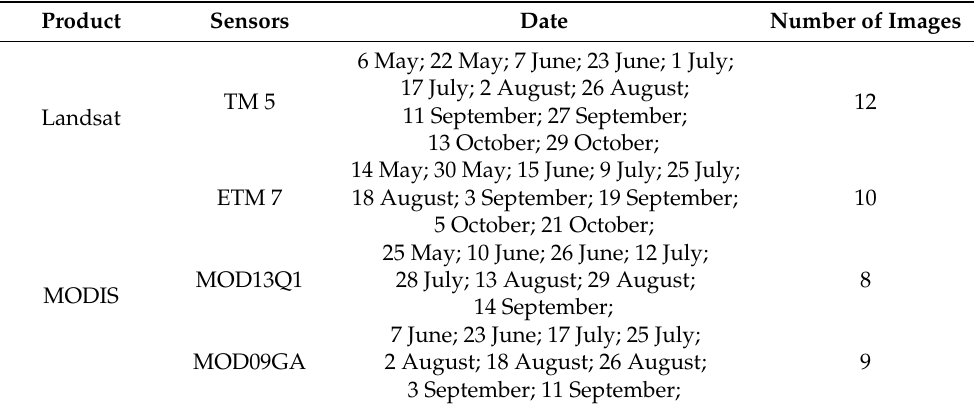
Table 1. Dates and number of Landsat and MODIS images used in the study over the cotton growing season from May to October in